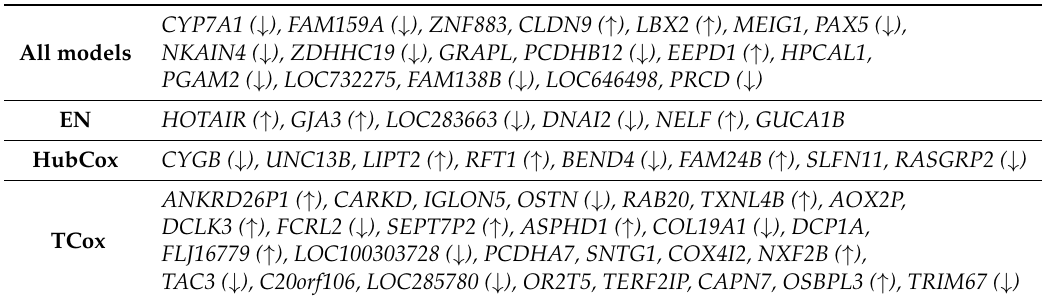
Genes selected by all models evaluated and selected exclusively by EN, HubCox, OrphanCox, and TCox . Arrows indicate if genes were found to be up- ( ↑ ) or down-regulated ( ↓ ) in tumoral tissue (differential gene expression analysis was performed using the edgeR R